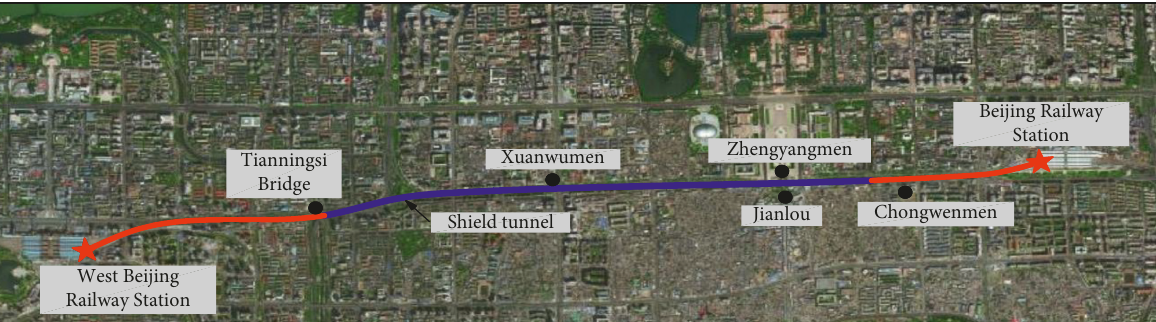
Figure 1: General layout of the RTLP.